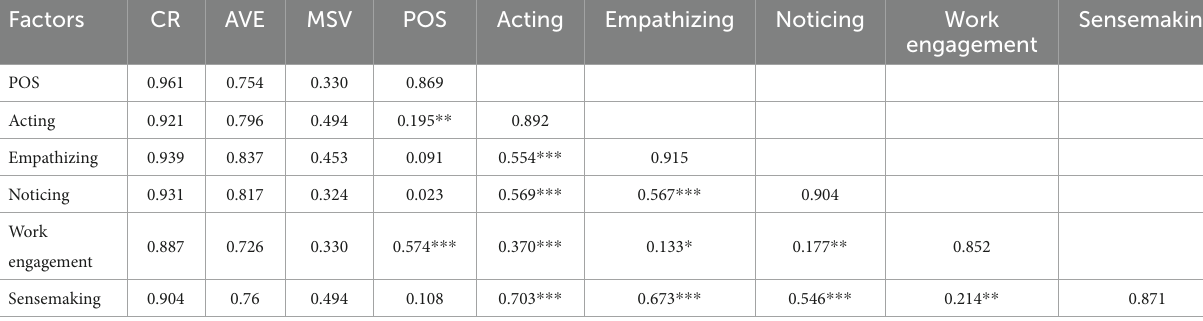
TABLE 7 Convergent and discriminant validity analysis for nomological network ( N = 255).